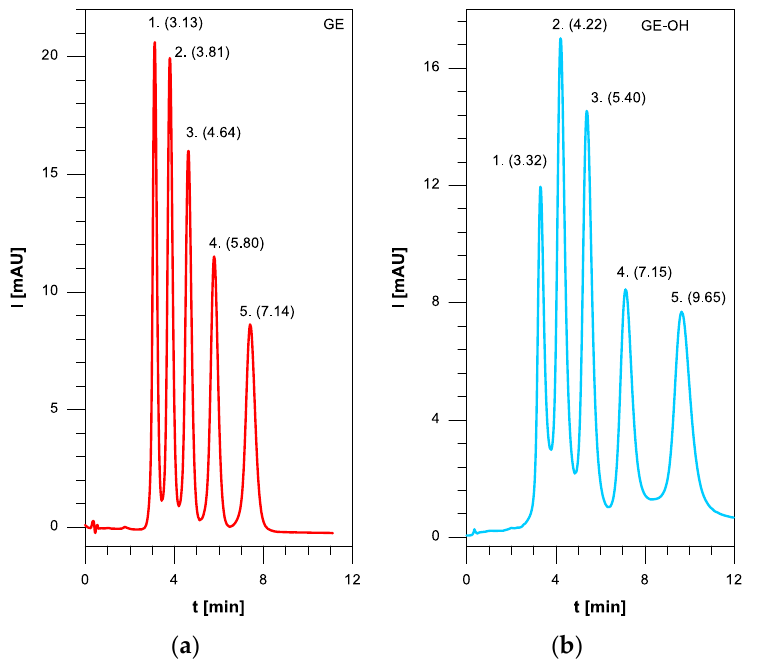
Figure 9. Separation of the mixture of homologous alkyl benzenes, ACN-buffer: ( a ) GE; ( b ) GE-OH.